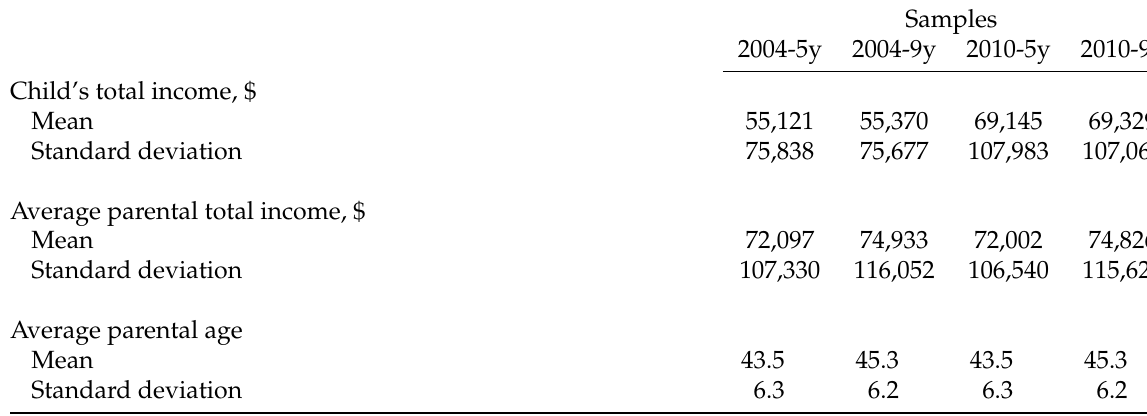
Table 2: Income and parental-age statistics (weighted